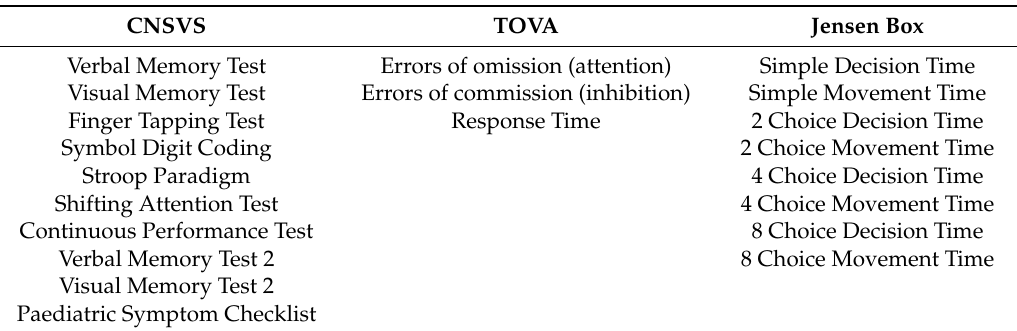
Table 2. Cognitive tasks &